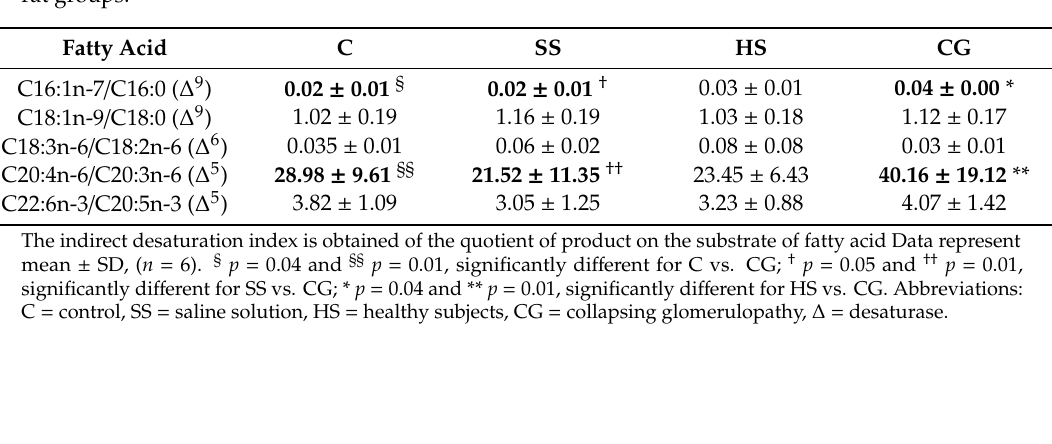
Table 5. Indirect desaturation indexes of the desaturases in the kidney homogenates of the experimental rat